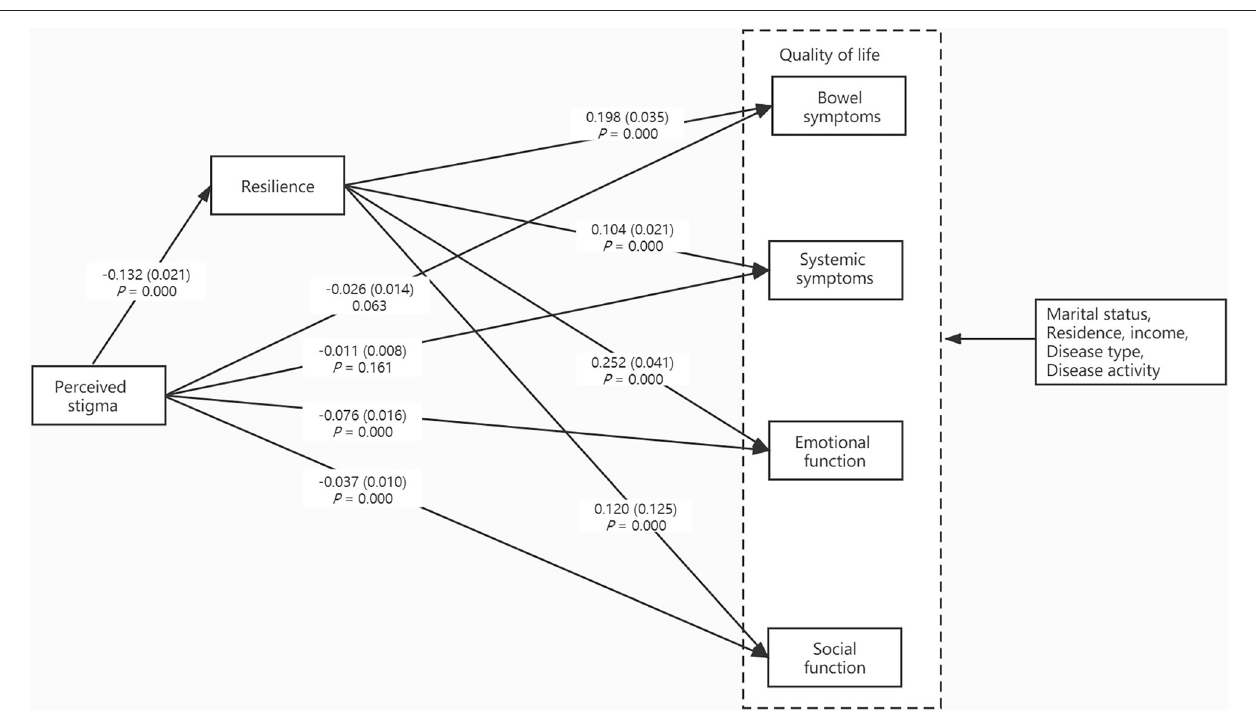
FIGURE 2 | The mediation model of perceived stigma, resilience, quality of